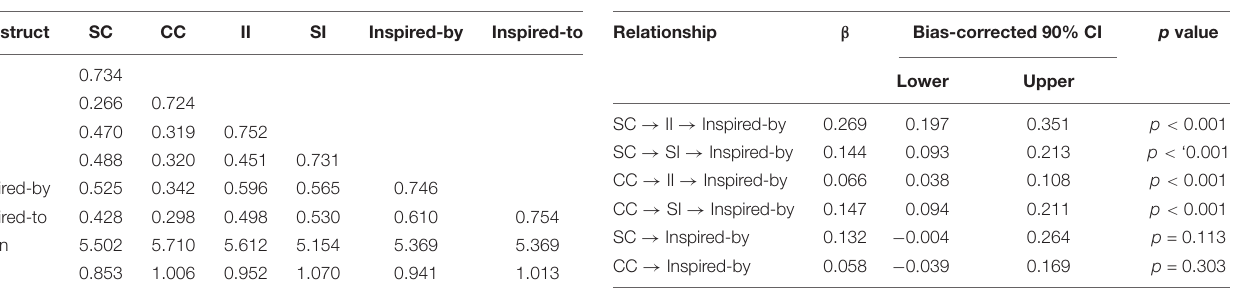
TABLE 3 | Mean, standard deviation, and correlation matrix. TABLE 5 | Mediation test.